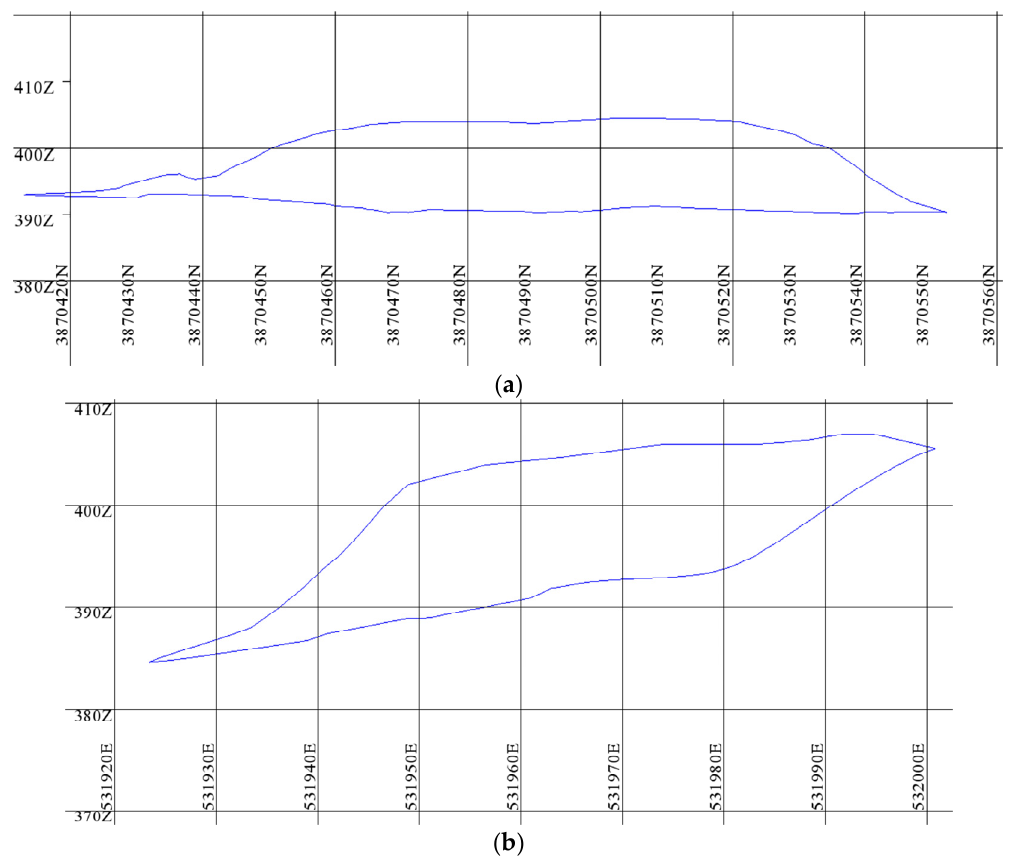
Figure 15. Stockpile STK1 sections in the ( a ) north–south direction and ( b ) west–east direction.